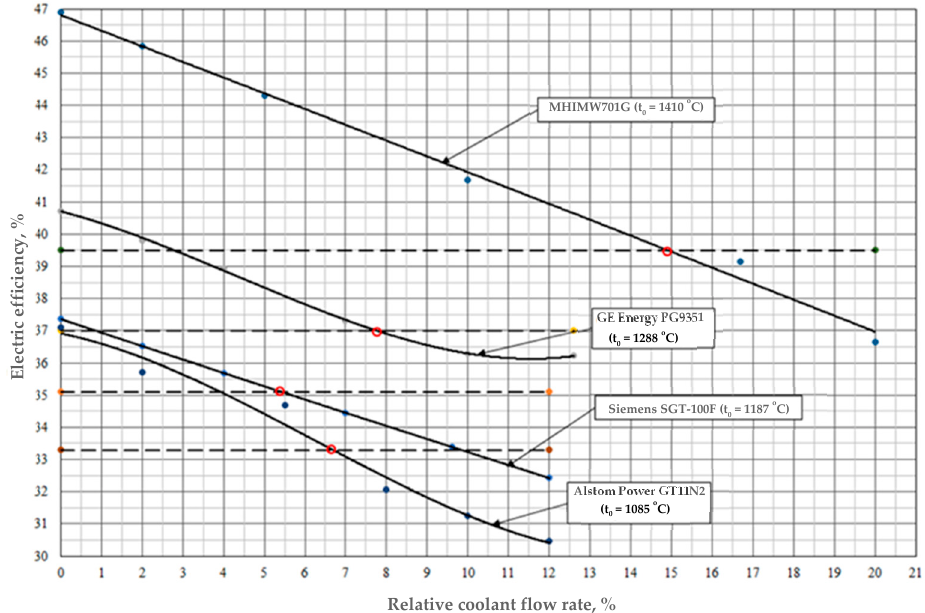
Figure 3. Dependences of changes in the electrical efficiency of GTU with different levels of power and temperatures on the relative flow rate of the coolant.